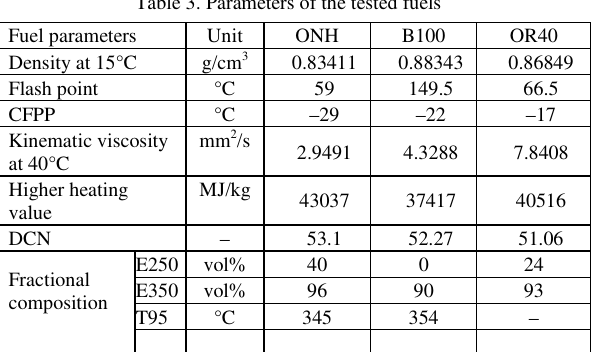
Table 3. Parameters of the tested fuels